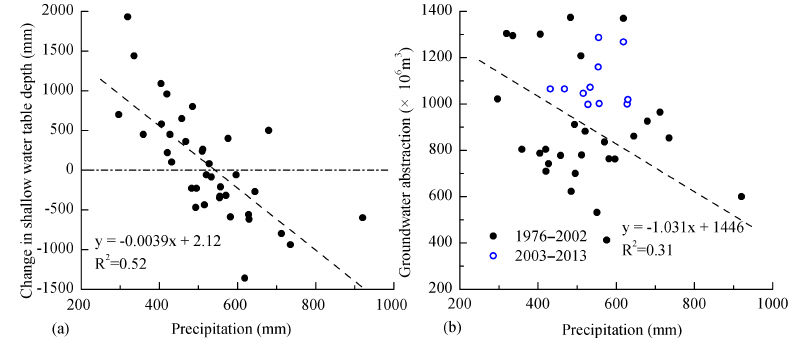
Figure 6. (a) Change in shallow water table depth; (b) total water withdrawal against annual